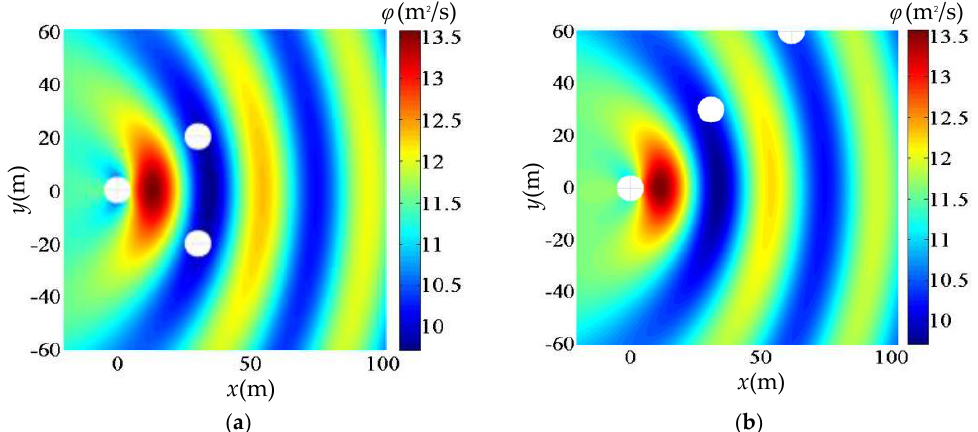
Figure 12. Layout and velocity potential of homogeneous distribution for the three-float array: ( a ) equicrural triangle; ( b ) straight line. Table 6. Energy capture coefficient of the WEC array ( N = 3) under different homogeneous distributions.